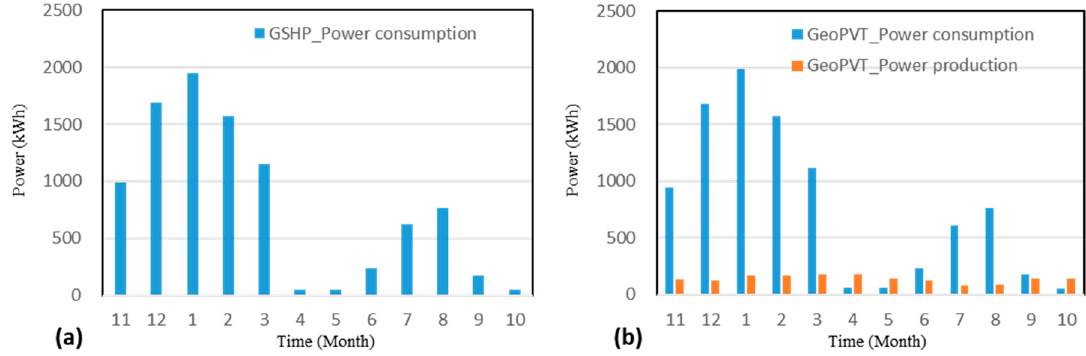
Figure 39. Power consumption and production of system in 165 m 2 . ( a ) GSHP; ( b ) Geo-PVT.